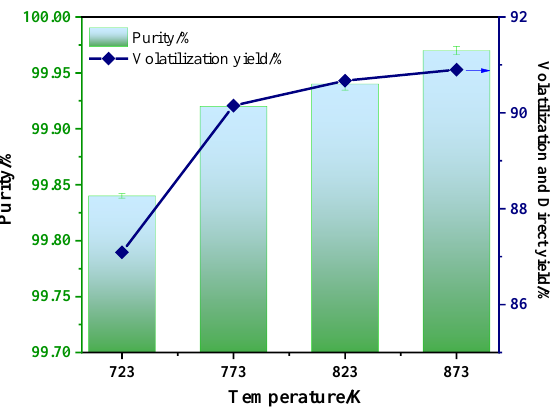
Figure 6. The purity and volatility of magnesium in relation to the condensing temperature. Based on the optimal selection of the above experimental conditions, 10 g of magne- sium alloy was used as the raw material, the system pressure was 100 Pa, the distillation temperature was 1073 K, the condensation temperature was 873 K, and the experiment was carried out for 30 min. The experimental results are shown in Figures 7–9 and Table 3.